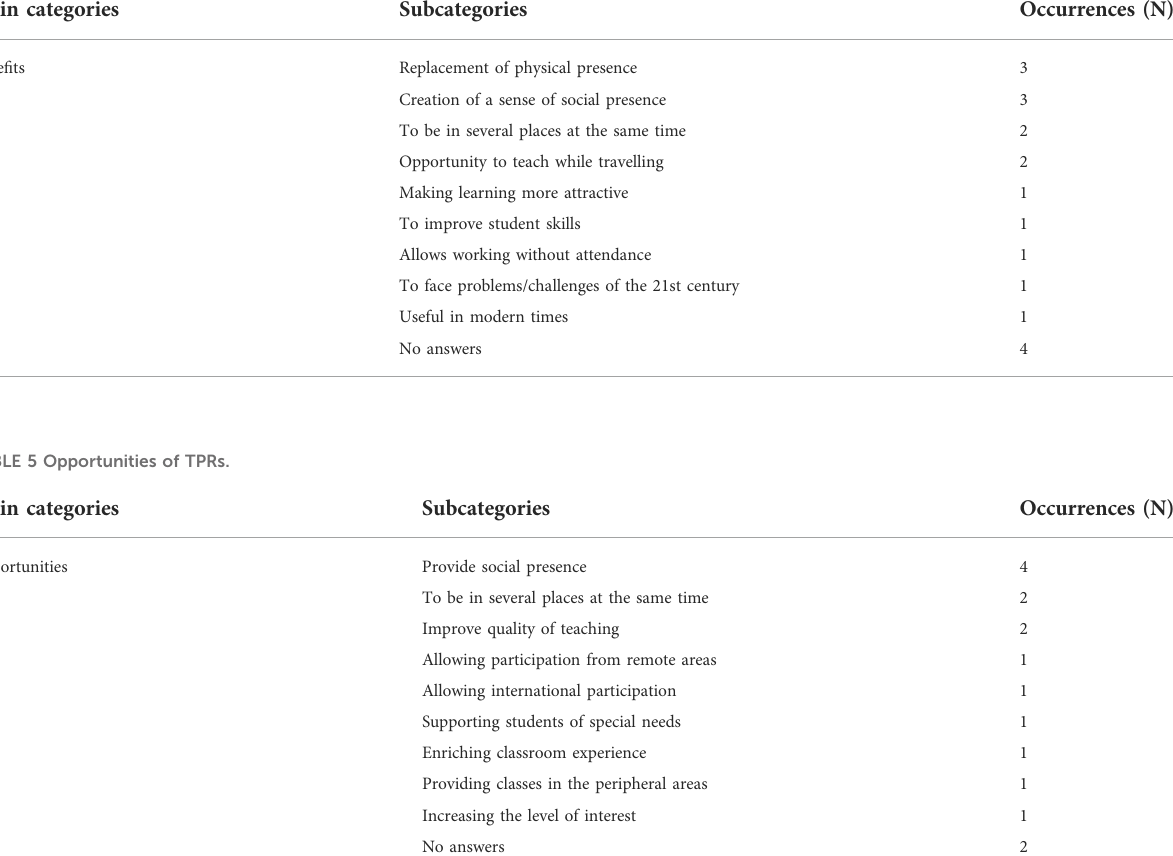
TABLE 4 Bene fi ts of TPRs.